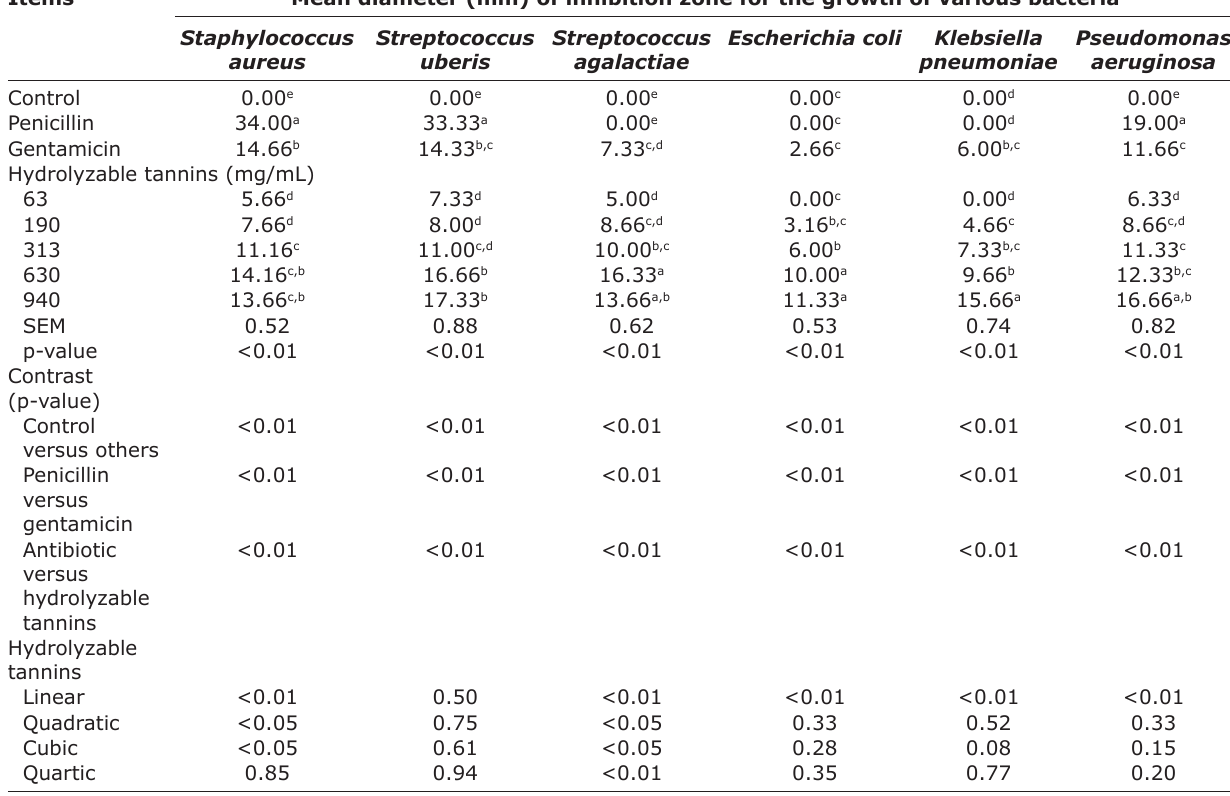
Table-1: Growth inhibition zones (mm) for different bacteria at a concentration of penicillin, gentamicin, and hydrolyzable tannins. Items